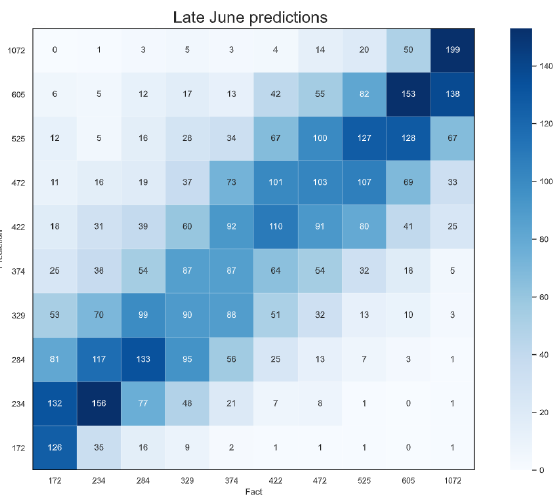
Figure 18. Early Predictions: Late-June.